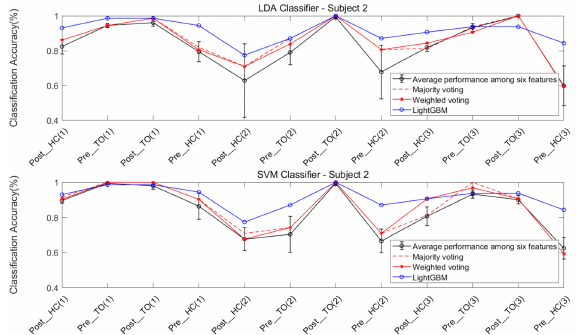
Figure 13. Classification performance for the ensemble learning method; Subject